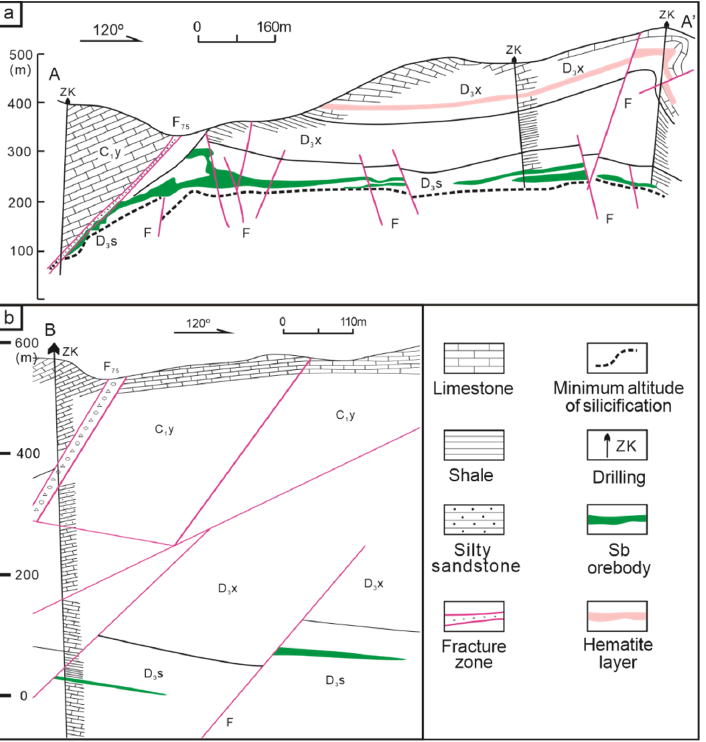
Figure 3. ( a ) A typical profile map of the Xikuangshan Sb deposit (Modified from [25]). ( b ) A typical profile map of the Daocaowan Sb deposit.